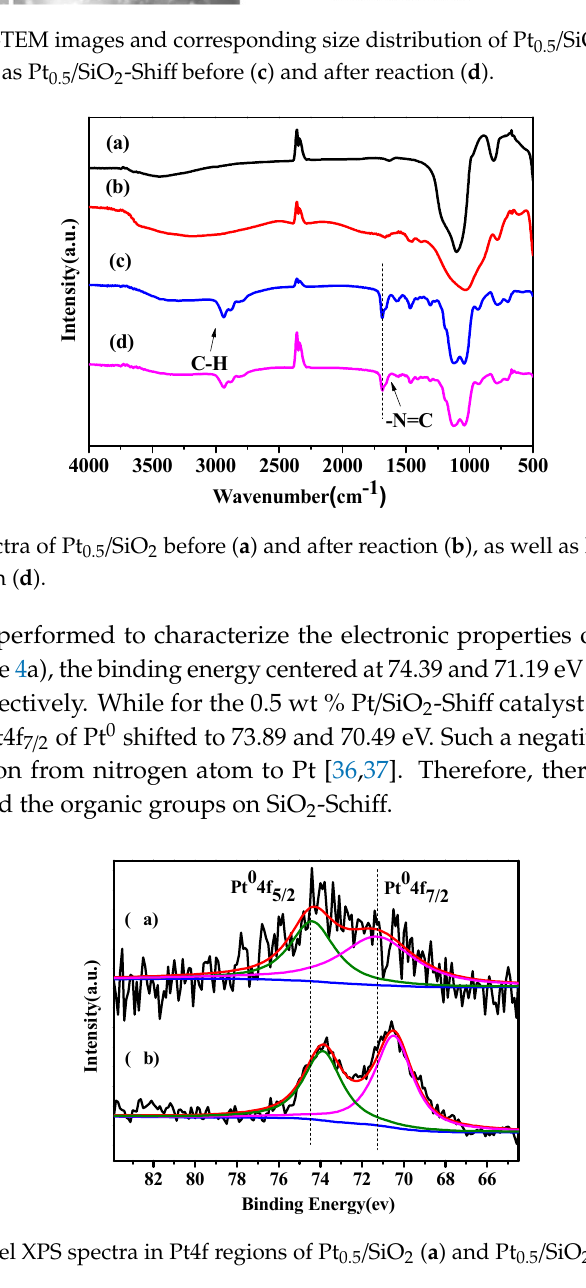
Figure 4. Core level XPS spectra in Pt4f regions of Pt 0.5 /SiO 2 ( a ) and Pt 0.5 /SiO 2 -Schiff ( b ) catalysts.